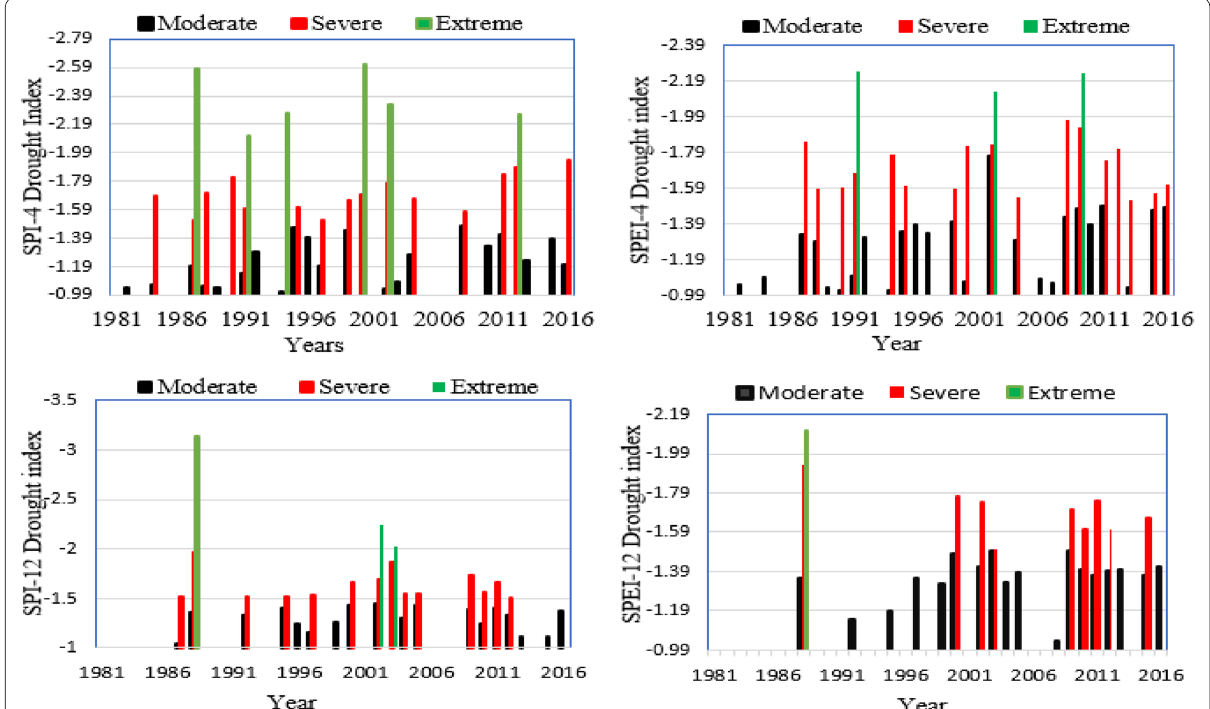
Fig. 4 Evaluation of the mean SPI/SPEI for 4- and 12-month timescales for moderate, severe, and extreme drought events in OGRB from 1981 to 2017